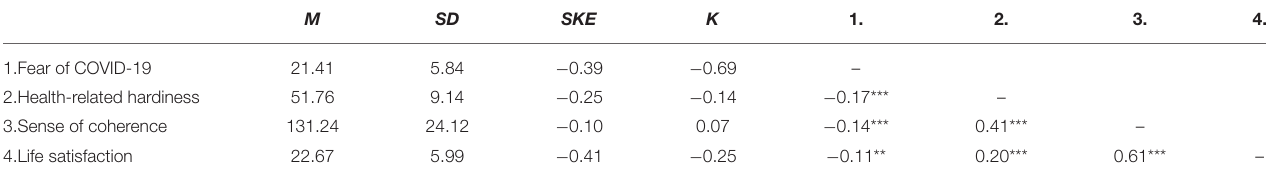
TABLE 2 | Results of Pearson’s r correlation analysis ( N =